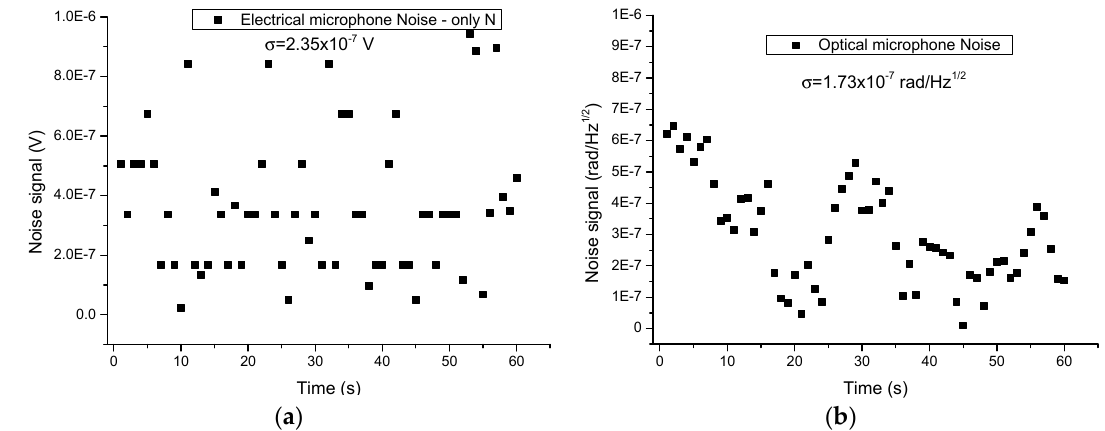
Figure 13. Noise signal for the acquired 2f-WMS photoacoustic signal for pure N 2 . ( a ) Electrical microphone and ( b ) Optical microphone.